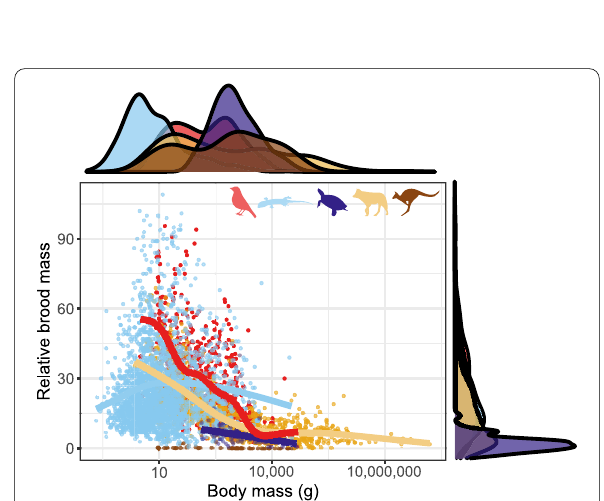
Fig. 10 Allometry of relative brood mass (in % of female mass). Red: birds; blue: squamates; purple: turtles; yellow: placental mammals; brown: marsupial mammals. Note that density plot of relative brood mass and regression line for marsupials are not shown because values are very close to zero. Solid regression lines are from Generalized Additive Models with knots (K 9). Note that x-axis is log 10 scaled =